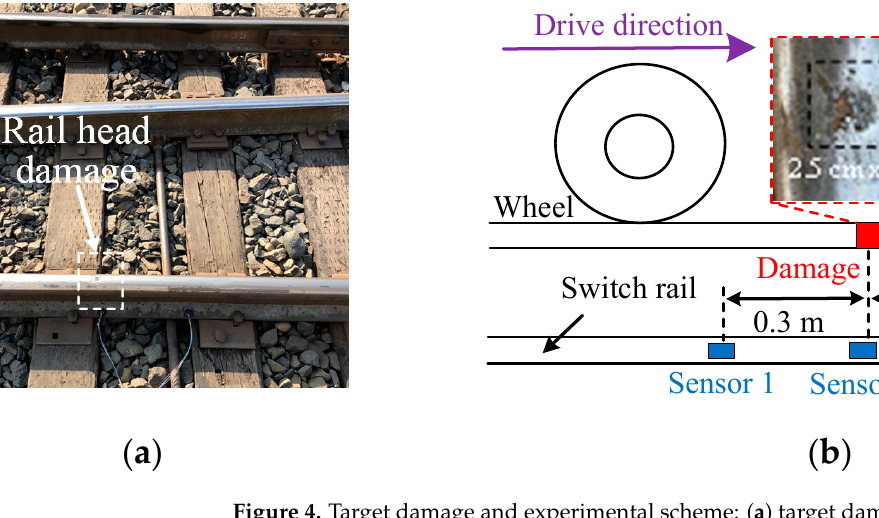
Taking the vibrations of the vehicle passing through the damage and nearby areas at